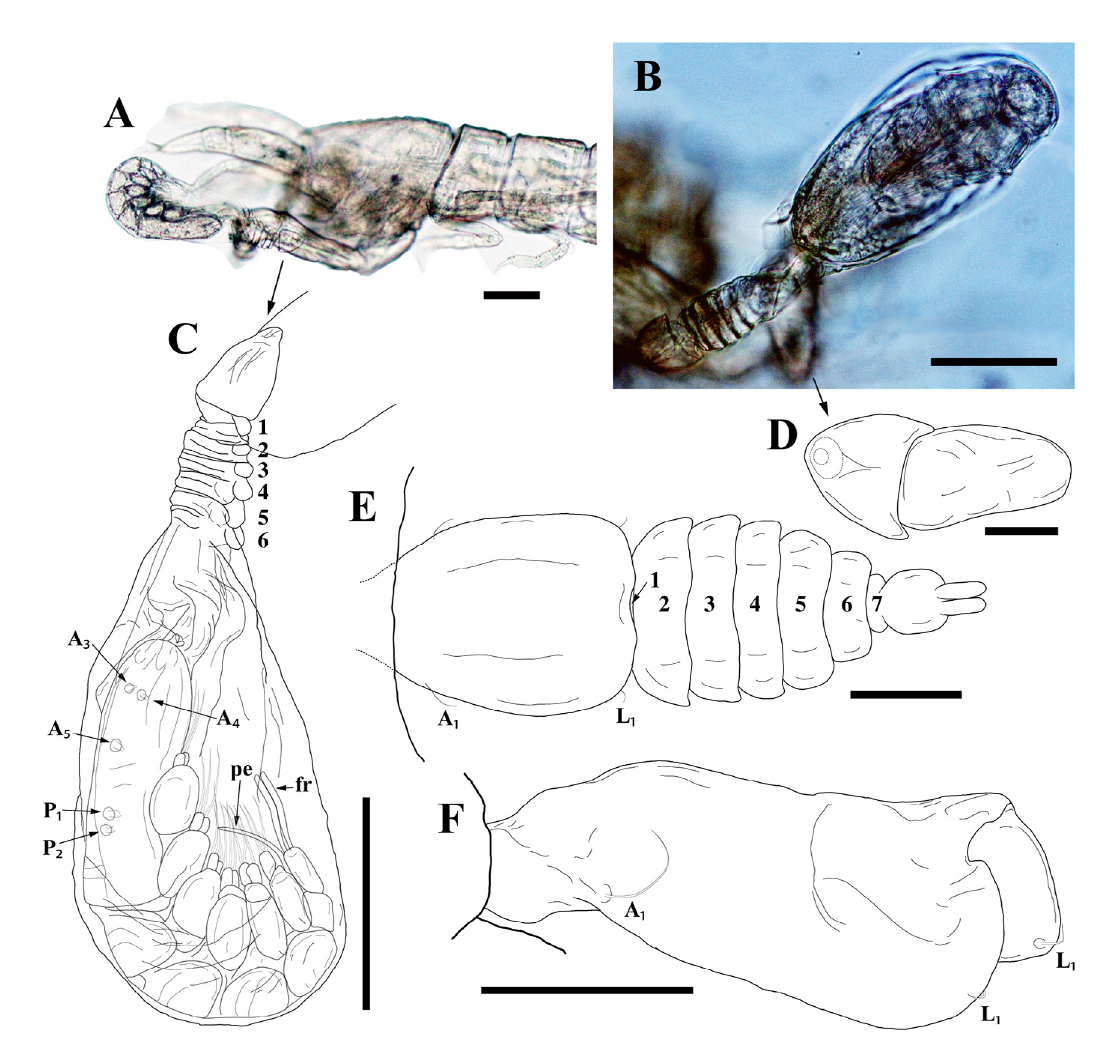
Figure 1. Microdajus sp. A ) Expanded tantulus larva, lateral view, with developing male (330 µm) attached to pereopod 1 of male Typhlotanais sp. (USNM 1640974, photographic specimen 2671.1). B ) Expanded tantulus larva, dorsal view, with developing male inside trunk sac, ventral view (male rotated relative to larva) (USNM 1640974, photographic specimen 2671.1). C ) Expanded tantulus larva with developing male inside trunk sac, lateral view (USNM 1640974, photographic specimen 2671.1). D ) Expanded tantulus bearing early trunk sac, dorsal view (body outline only, no setae drawn; oral disc observed through cephalon shown in dashed line) (USNM 1640974, photographic specimen 2671.2). E ) Tantulus larva, dorsal view (traced from light and SEM images; USNM 1640972). F ) Cephalon of tantulus larva, lateral view (traced from SEM image; USNM 1640972). Abbreviations: A P = cephalic pores with setae; fr = furcal rami; pe = penis. Scales = 100 µm (A–C); 25 µm (D); 10 µm (E, 2